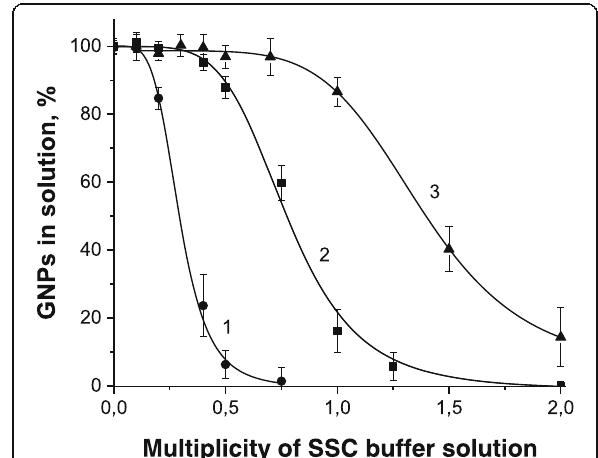
Fig. 1 The influence of ionic strength (multiplicity of SSC buffer solution) on the level of light extinction at 520 nm of the unmodified GNPs ( 1 ) and two preparations of GNPs modified by the thiolated oligonucleotides T2-18m — one sample with the average number of 13 DNA strands per particle ( 2 ) and the other with the average number of 22 DNA strands per particle ( 3 )